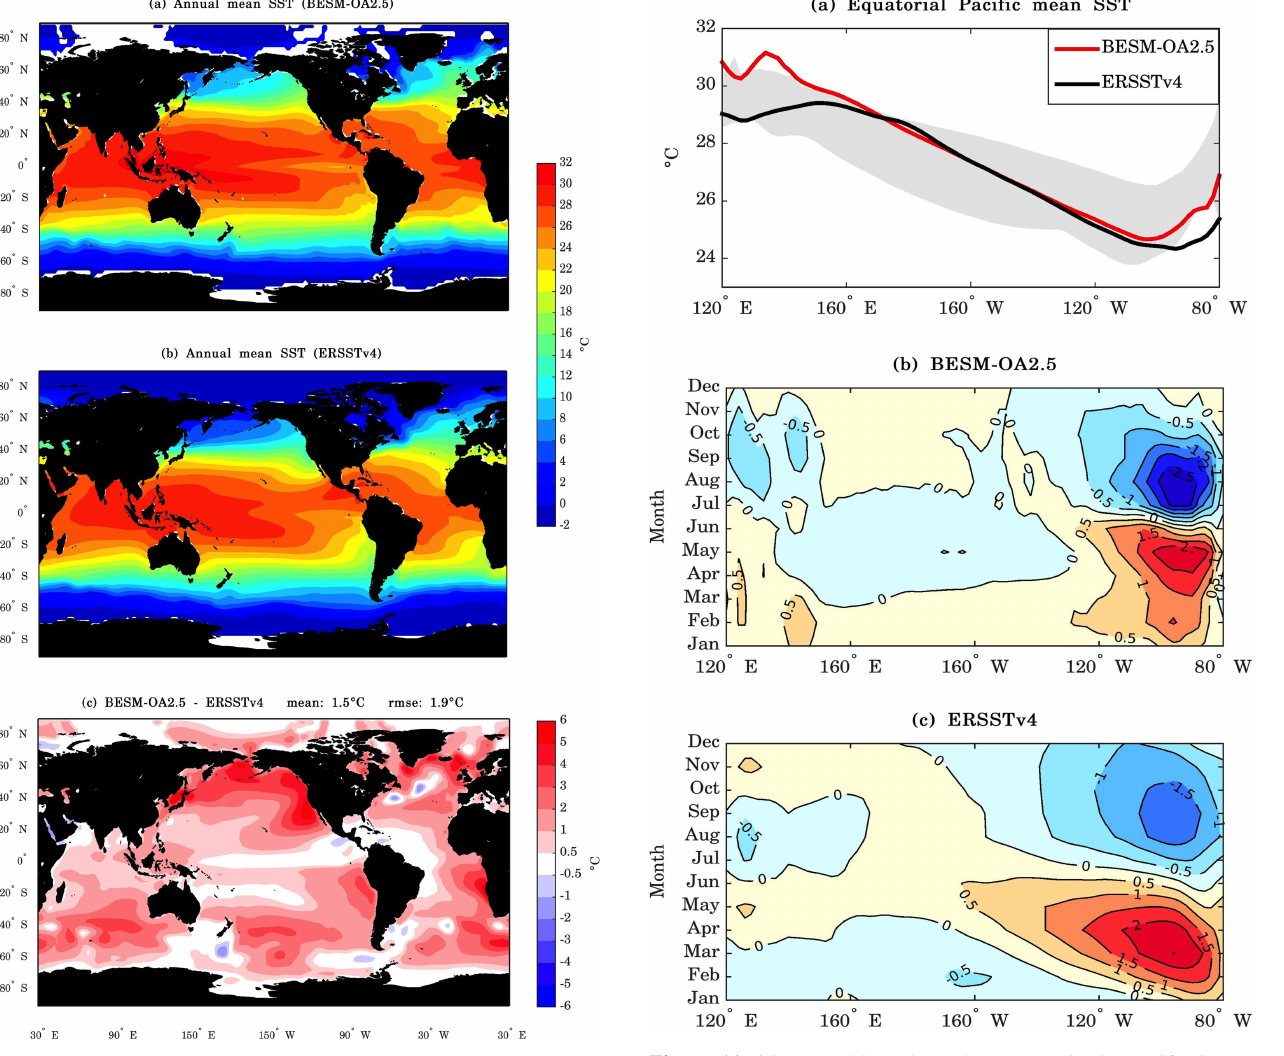
Figure 10. Spatial maps of the annual mean sea surface tempera- tures generated by (a) BESM-OA2.5 and (b) ERSSTv4, and (c) the bias of BESM-OA2.5 relative to ERSSTv4. The averages were computed over the period 1971–2000. Units are in degrees Celsius.